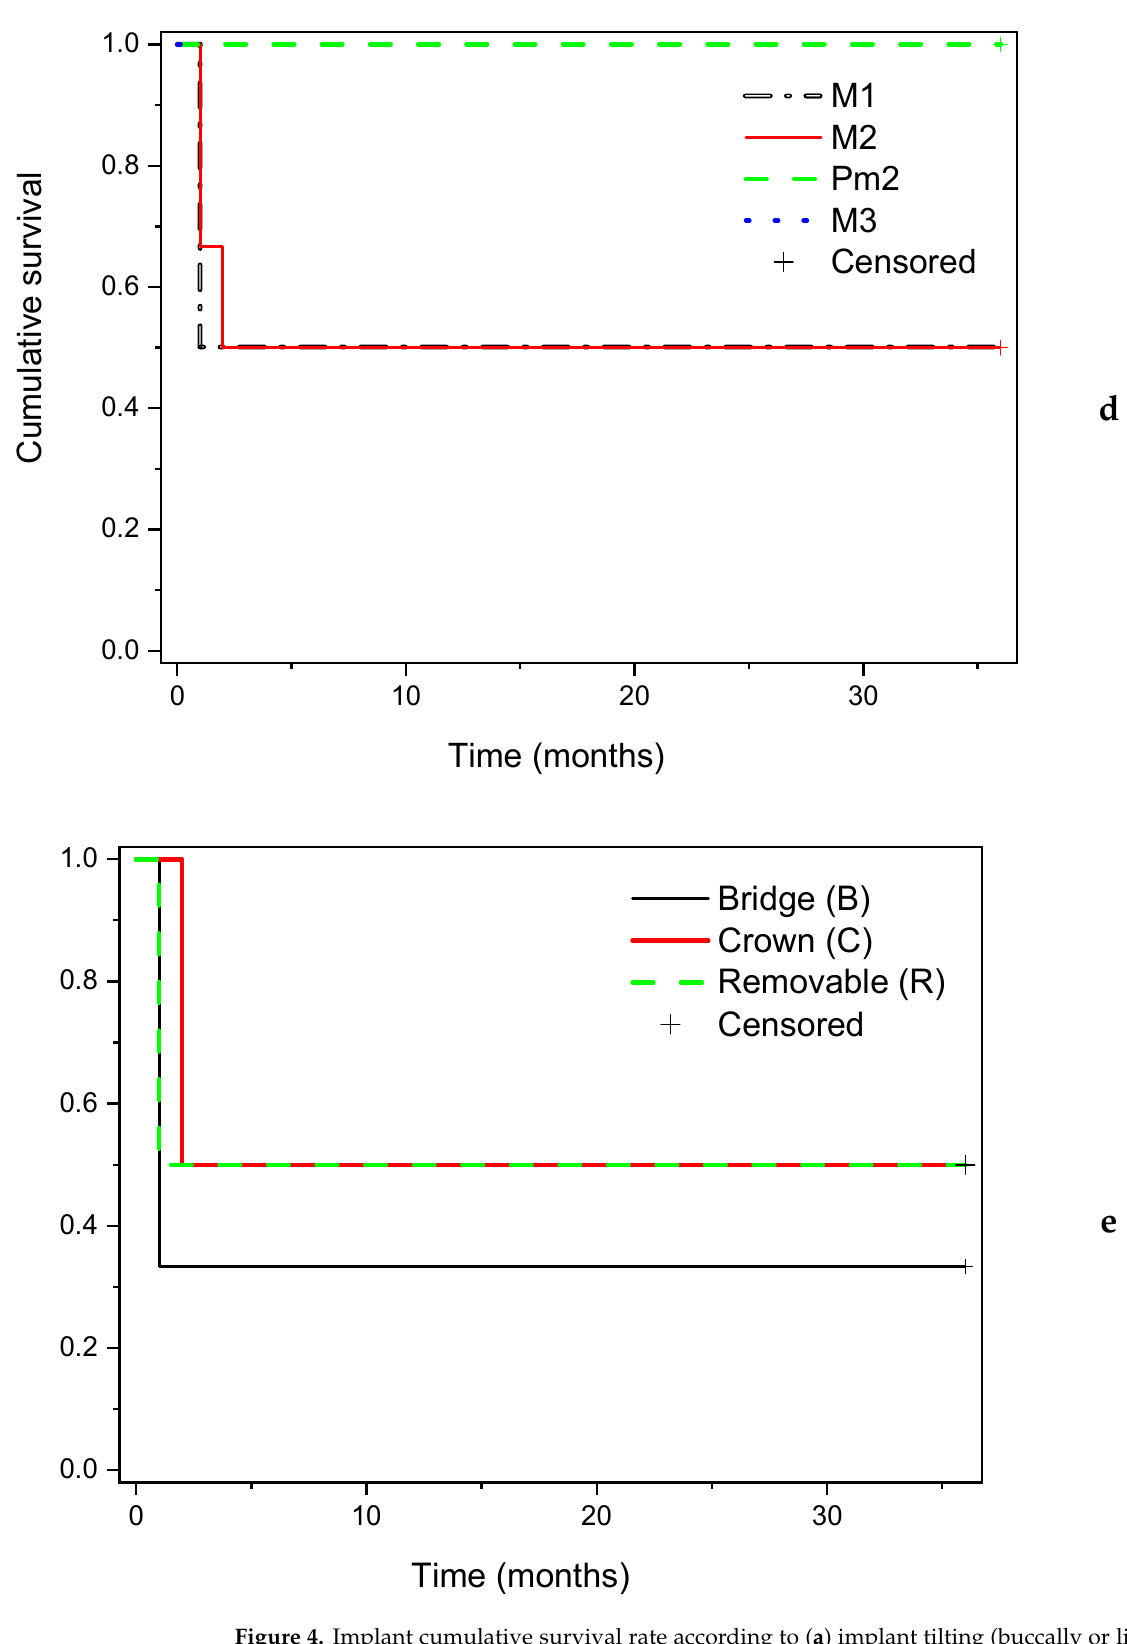
Figure 4. Implant cumulative survival rate according to ( a ) implant tilting (buccally or lingually); ( b ) implant diameter (in mm); ( c ) implant length (in mm); ( d ) implant position (M1—first molar, M2—second molar, Pm2—second premolar, M3—third molar); ( e ) type of prosthetic restoration (fixed—bridge or single crown, and removable—implant retained overdenture). No statistically significant differences regarding implant survival related to implant tilting (log rank: χ 2 = 3.22, df = 1, p = 0.07), implant diameter (log rank: χ 2 = 4.23, df = 2, p = 0.12), implant length (log rank: χ 2 = 5.20, df = 3, p = 0.16), implant position (log rank: χ 2 = 2.07, df = 3, p = 0.56) or prosthetic restoration (log rank: χ 2 = 0.34, df = 2, p = 0.84) were observed. 3.1. Assessment of Neurosensory Disturbance (NSD) Seven patients (85.71%) with twelve implants sites showed a positive response when subjected to the tactile point pressure sensitivity test using the Semmes–Weinstein approach. Tactile point pressure neurosensitivity tests results revealed that 1 patient (patient no. 6 from Table 1) showed disturbances in all 3 regions, while a second patient (patient no. 1) showed NSD in the evaluated regions 1 and 2 at 24 h follow-up assessment.